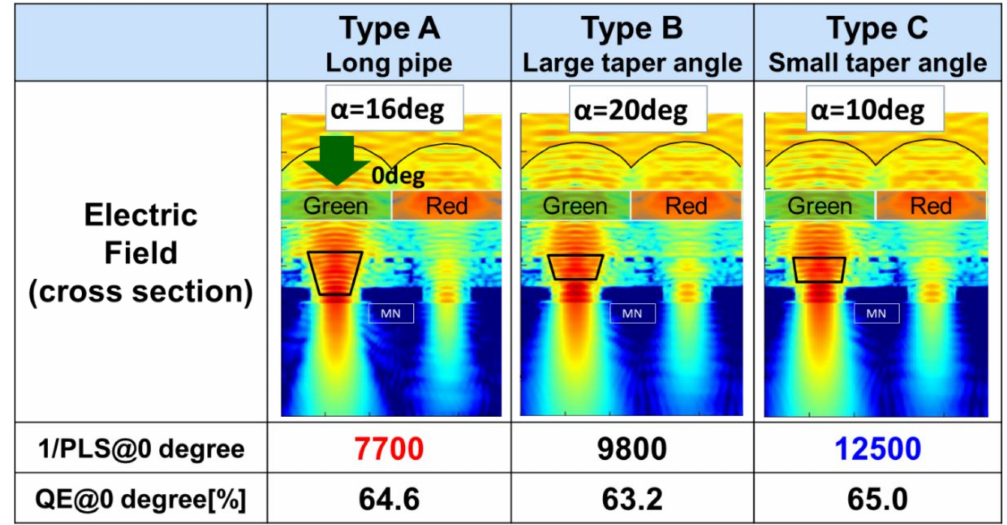
Figure 7. Comparison of three types of light pipes at an incident angle of 10 degrees.